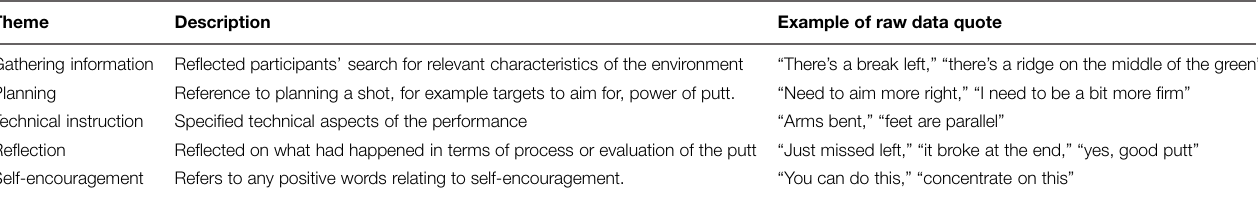
TABLE 1 | Coding scheme framework adapted from Calmeiro and Tenenbaum